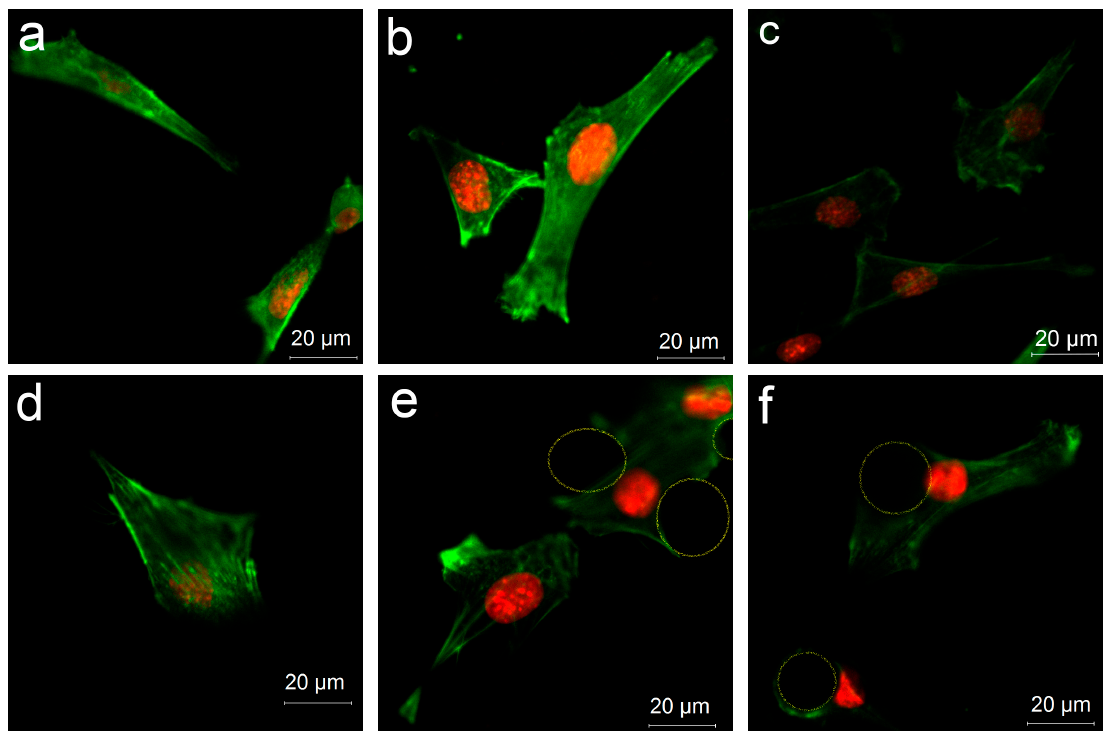
Figure 6. The fluorescence staining images representing the distribution of cells ( a ) S, ( b ) B, ( c ) BS.